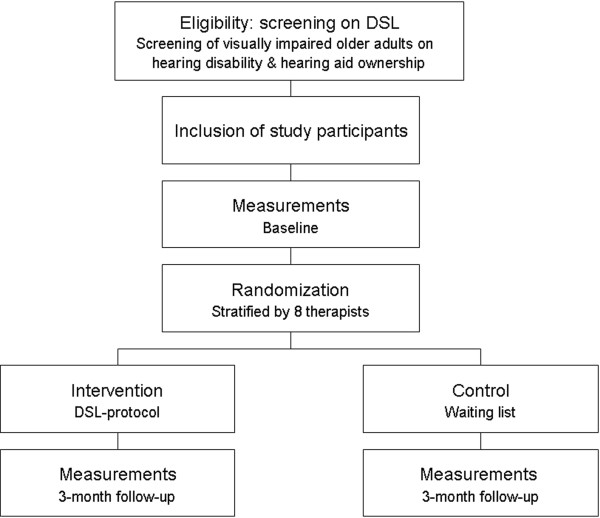
Design of the trial.